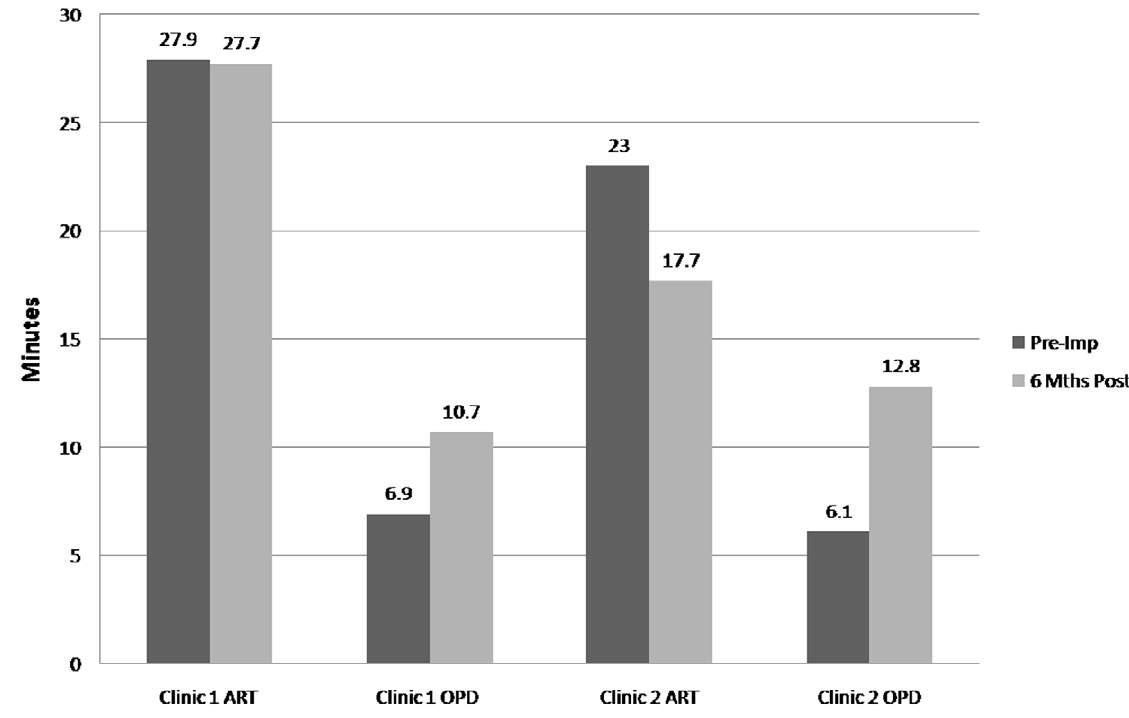
Figure 4. Median time spent with any health care worker. doi:10.1371/journal.pone.0011522.g004 hemoglobin measured while on zidovudine between pre- and second quarter post-implementation (68.4%–60.6%, p = 0.04); no other indicators demonstrated significant change.